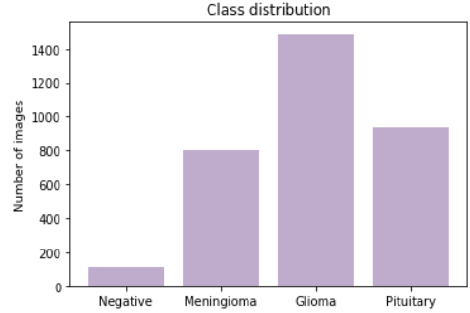
Figure 4. Initial Class Distribution of Brain Tumor